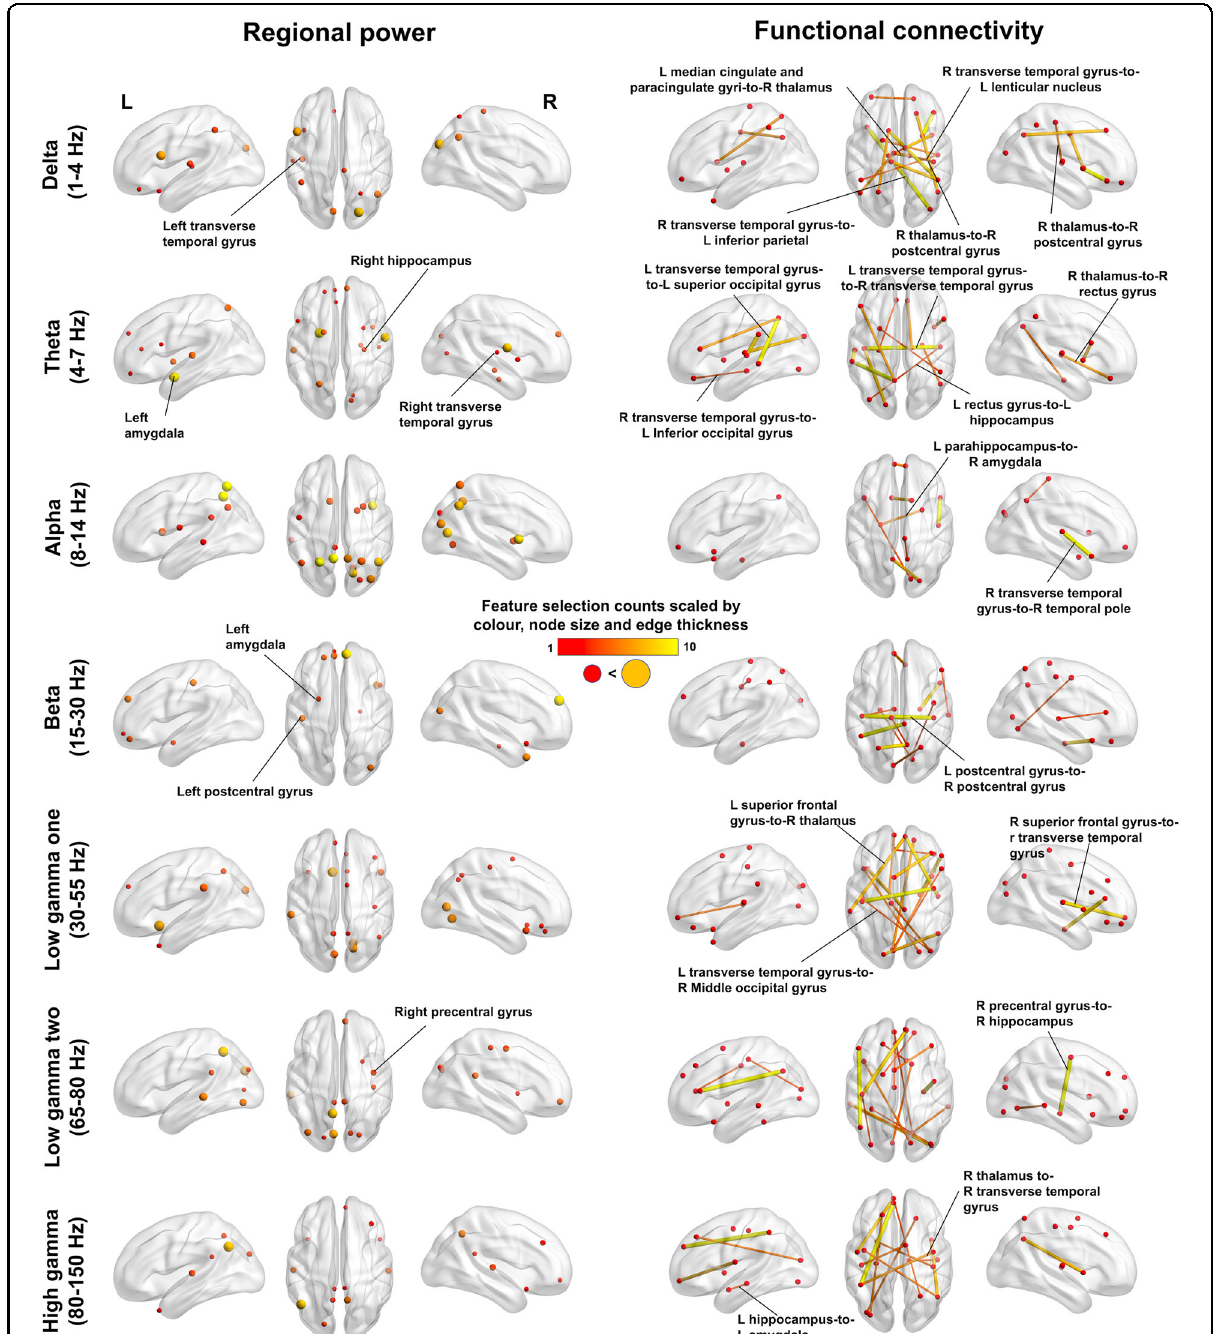
Fig. 3 Functional connectivity outperforms in feature selection count compared to regional functioning. Regional power and functional connectivity maps with only the CV-SVM-rRF-FS selected features for all seven frequency bands, with the most biologically relevant features marked. Thalamus, amygdala, hippocampus and superior temporal gyrus (i.e. transverse temporal gyrus) are marked for regional power fi gures; functional edges containing these regions are also marked for the functional connectivity fi gures. As identi fi ed by both data types, the right precentral gyrus was marked for the regional power and functional connectivity fi gures at the high gamma band. For the beta band, the statistically signi fi cant edge left postcentral gyrus-to-right postcentral gyrus (marked) was also identi fi ed by feature selection. CV-SVM-rRF-FS support vector machine and recursive random forest feature selection with cross